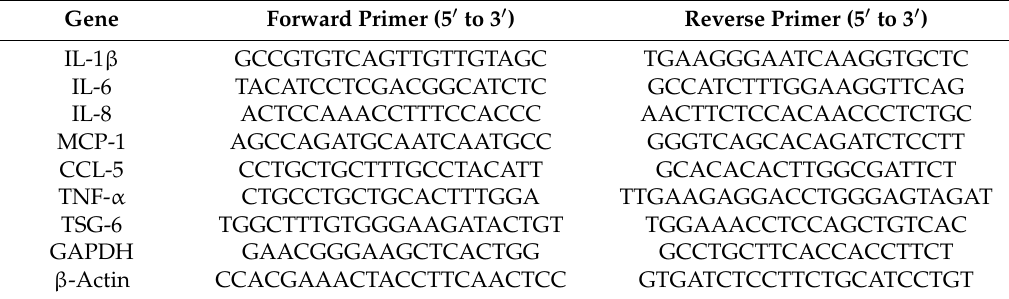
Table 1. The list of primers